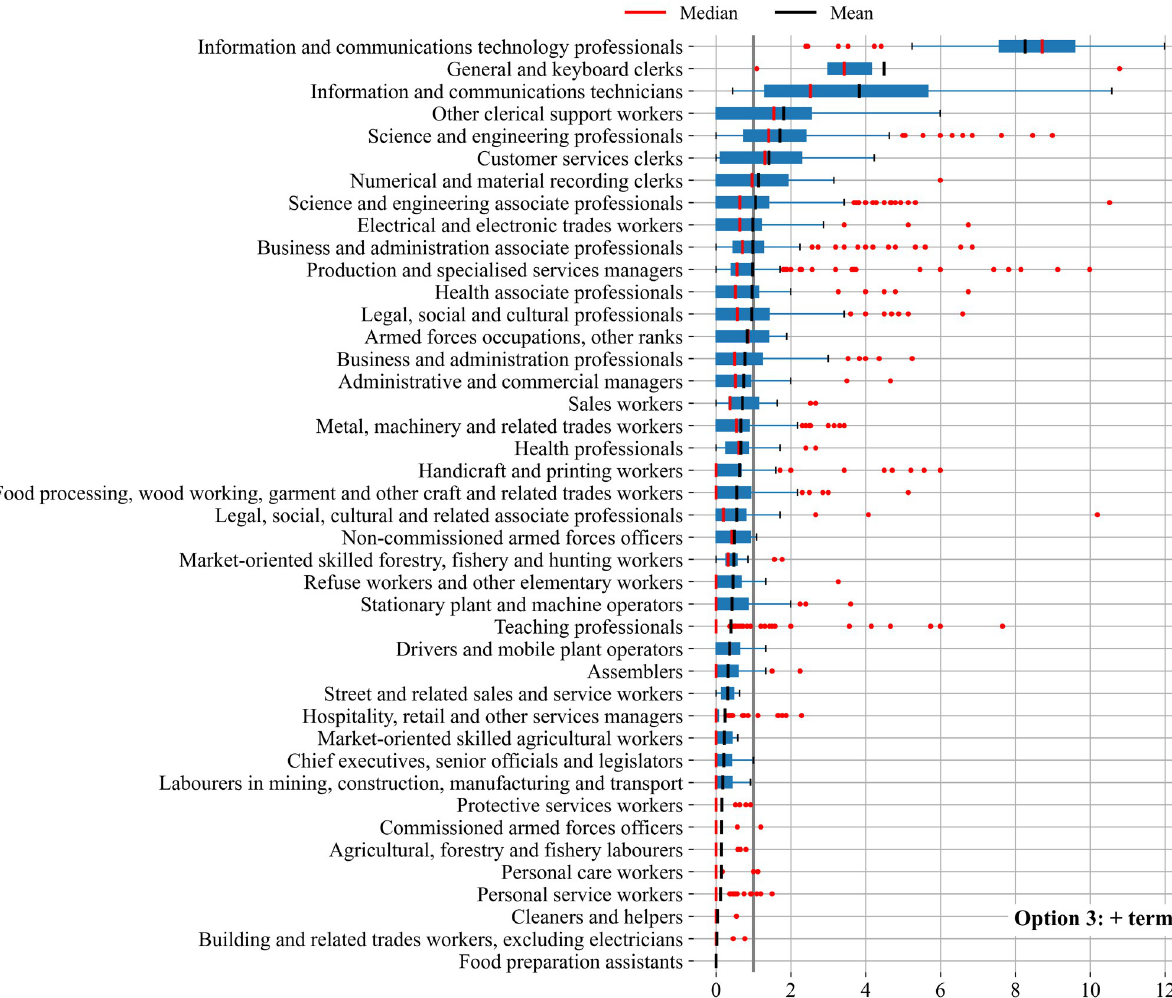
Fig 5. Boxplot of DCI by occupations: 2-digit ISCO code. Note: we have added a line at value one in order to visually distinguish occupation groups with a revealed comparative advantage from those with a revealed comparative disadvantage.